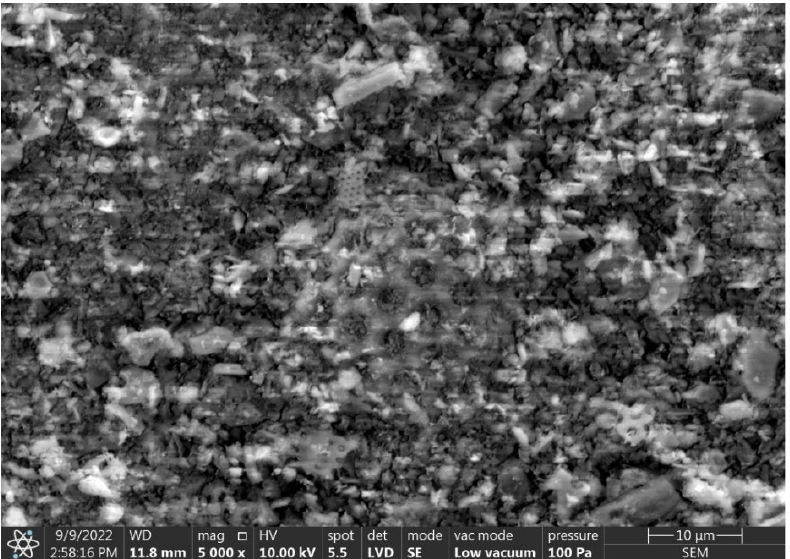
Figure 16. SEM images of the commercial sorbent (diatom shell in the center).